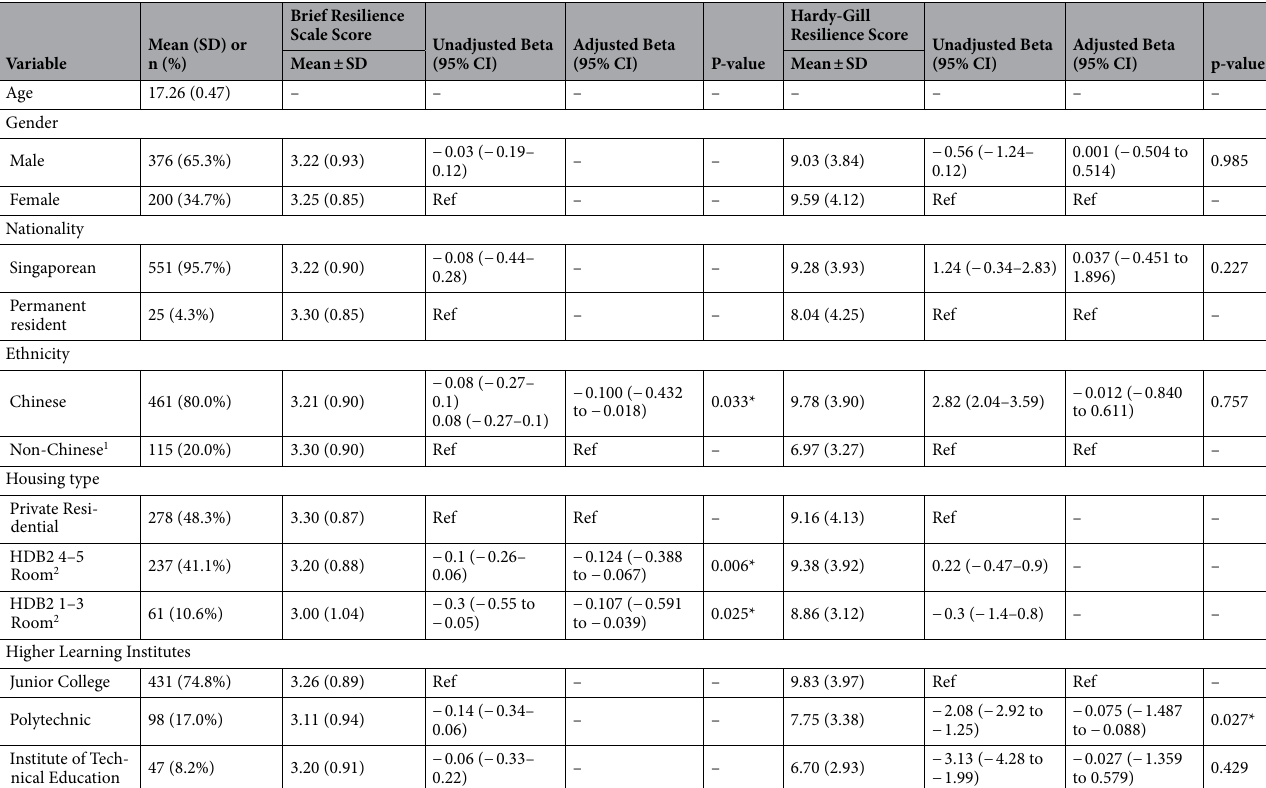
Table 1. Association between sociodemographics and resilience score. *p < 0.05. 1 Non Chinese = Malay, Indian and other ethnicity. 2 HDB = Singapore Housing Development Board (Public housing type is a surrogate indicator of socioeconomic status, with the more affluent living in larger apartments). Model for BRS is adjusted for ethnicity and housing type. Model for HGRS is adjusted for gender, nationality, ethnicity and education